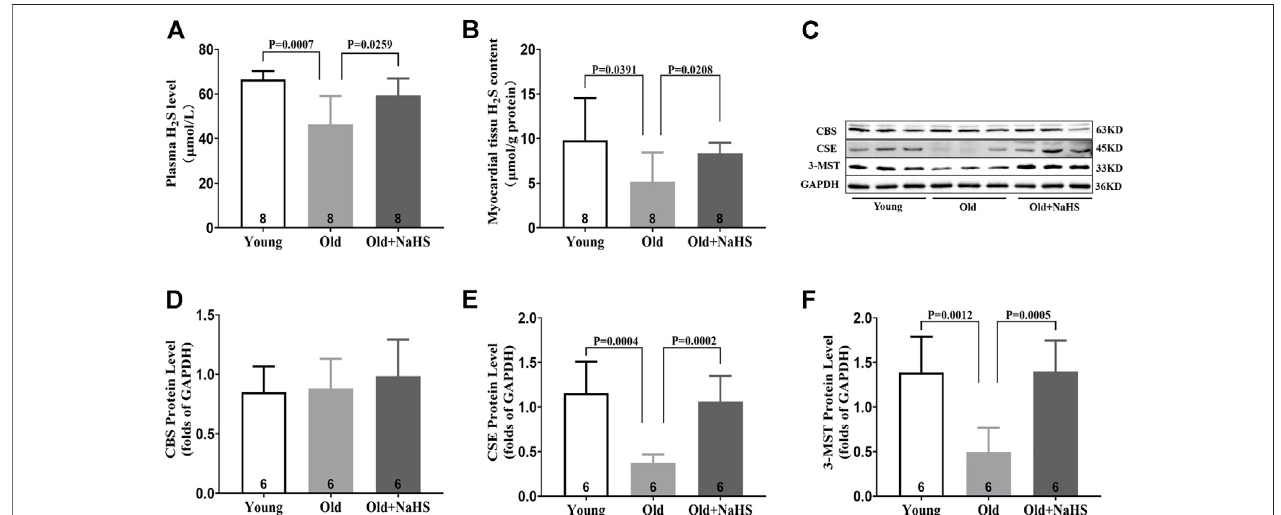
FIGURE 3 | Exogenous H 2 S enhanced H 2 S synthase expression in the myocardial tissue of aging rats. (A) H 2 S levels in the plasma of aging rats. (B) H 2 S levels in themyocardialtissueofagingrats. (C) RepresentativeWesternblotsforCBS,CSE,and3-MSTexpressionsinmyocardialtissuesofagingrats.GAPDHwasusedasthe internal control. (D) Quantitative analysis for CBS expression in the myocardial tissue of aging rats. (E) Quantitative analysis for the CSE expression in the myocardial tissue of aging rats. (F) Quantitative analysis for the 3-MST expression in the myocardial tissue of aging rats. Results are means ± SEM. A p -value of < 0.05 was considered signi fi cant.